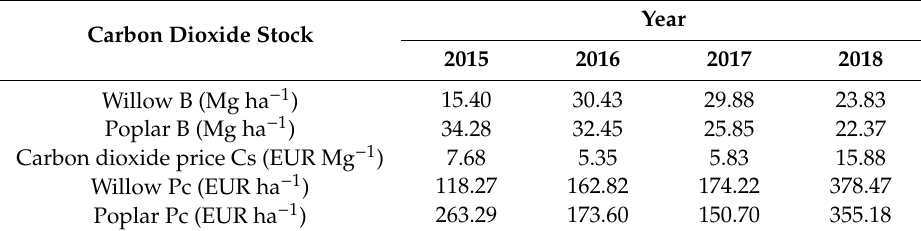
Table 4. Carbon dioxide sequestration of willow and poplar.